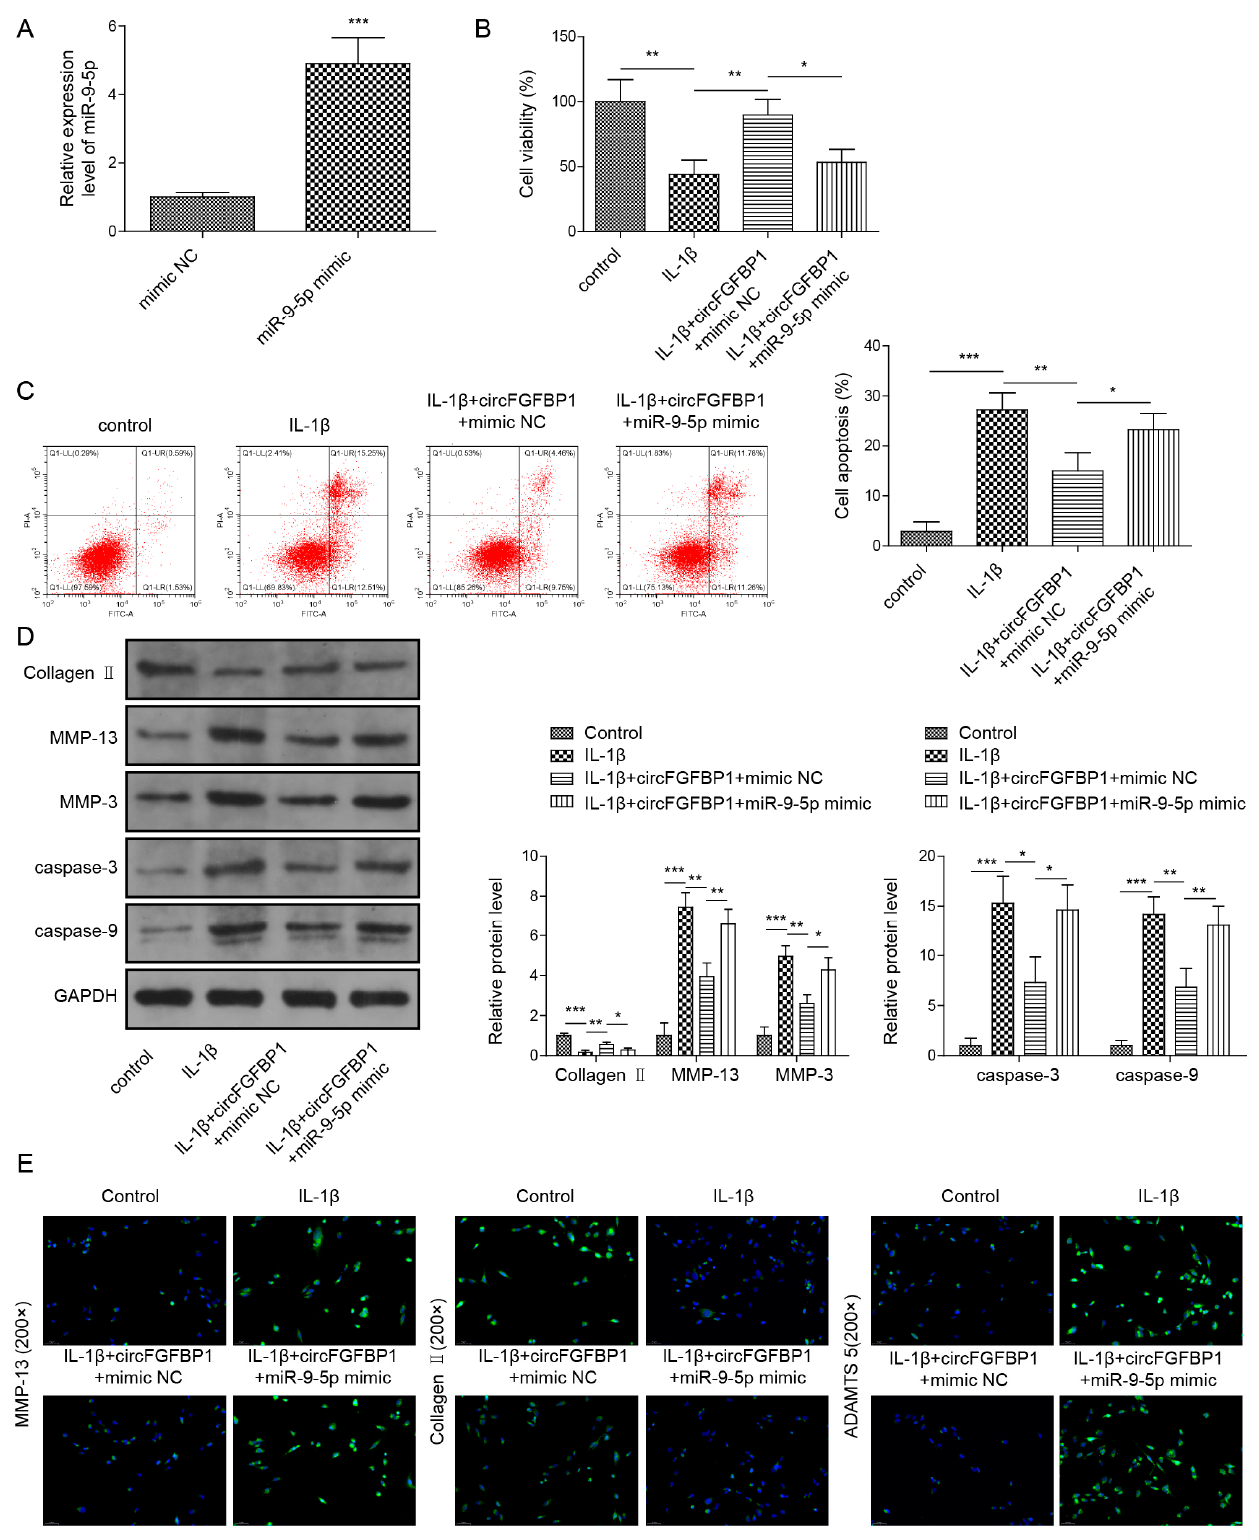
Figure 5. MiR-9-5p reverses apoptosis and ECM degradation inhibited by circFGFBP1 upregulation in NP cells. ( A ) MiR-9-5p expression by qPCR. ( B ) Cell viability by CCK-8 assay. ( C ) Apoptosis in NP cells by flow cytometry. ( D , E ) Expressions of ECM proteins by Western blot ( E ) and immuno- fluorescence ( E ). Data were estimated as mean ± SD. * p < 0.05, ** p < 0.01, *** p < 0.001.